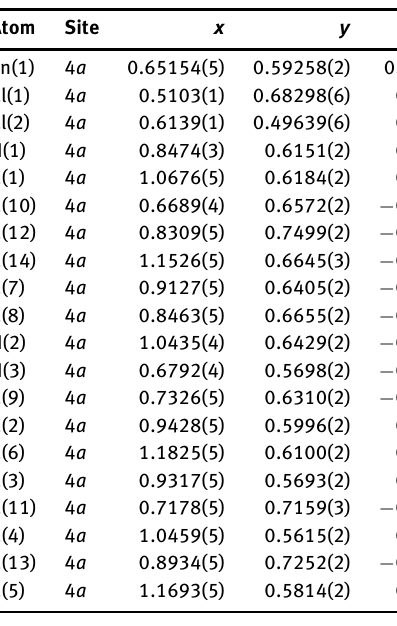
Table 3: Fractional atomic coordinates and atomic displacement parameters (Å 2